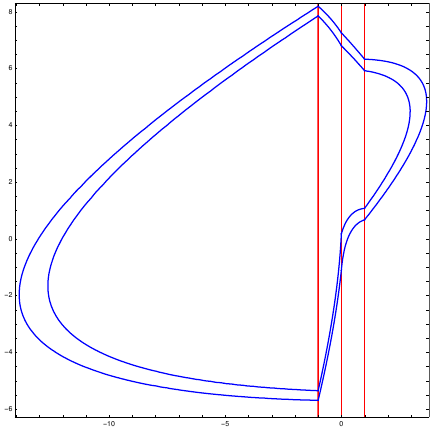
Figure 4. Two crossing limit cycles of PHS with four